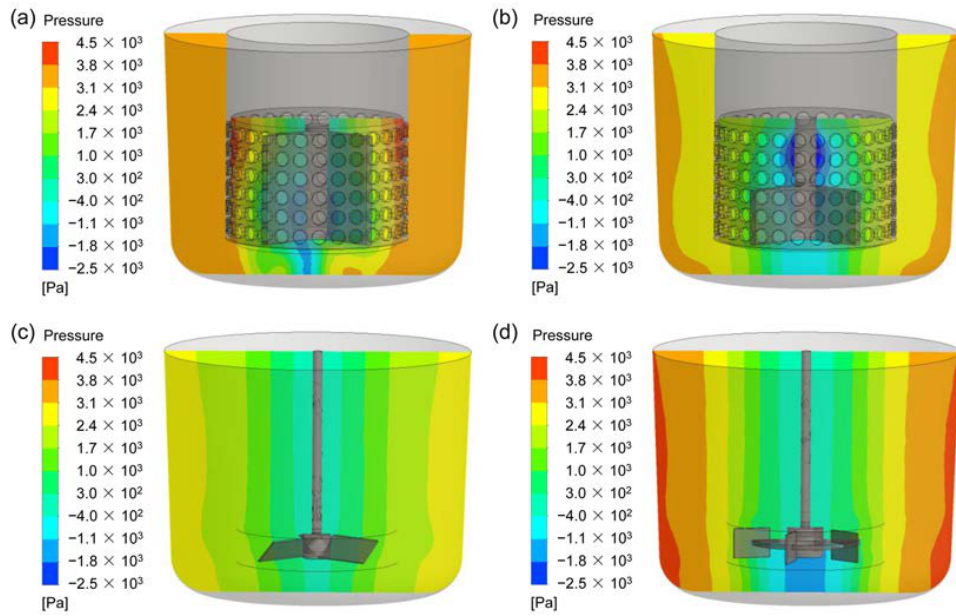
Figure 10. Pressure fields at the vertical plane for the four types of agitators at the stirring speed of 400 rpm; ( a ) CSRS agitator; ( b ) HCSRS agitator; ( c ) A200 agitator; ( d ) Rushton agitator.